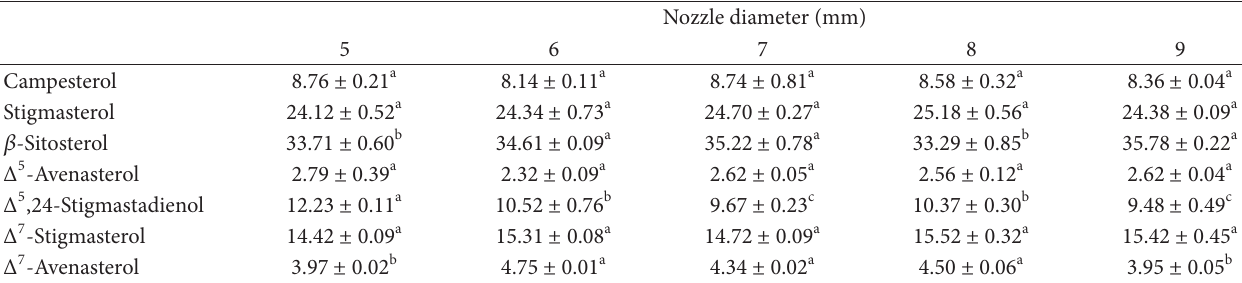
0.05. T 2: Variation of sterol composition (mg/100g oil) in different screw con�gurations. Nozzle diameter (mm) 5 6